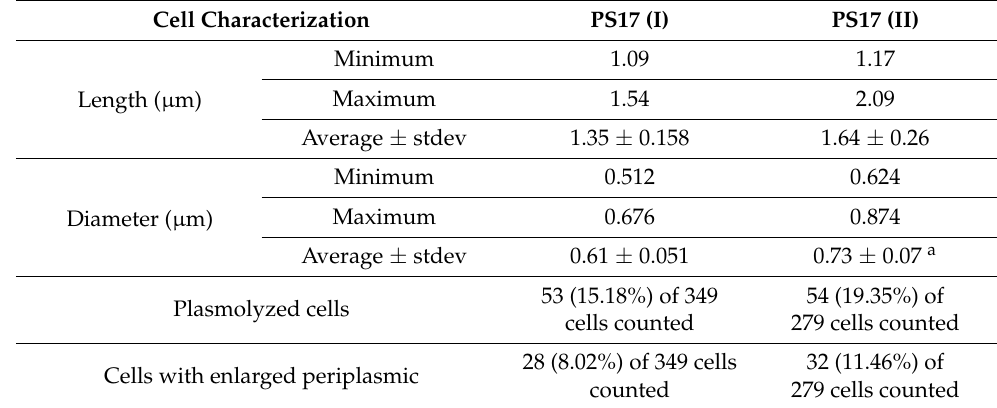
Table 2. Characterization of B. mojavensis PS17 cells observed under TEM after phase